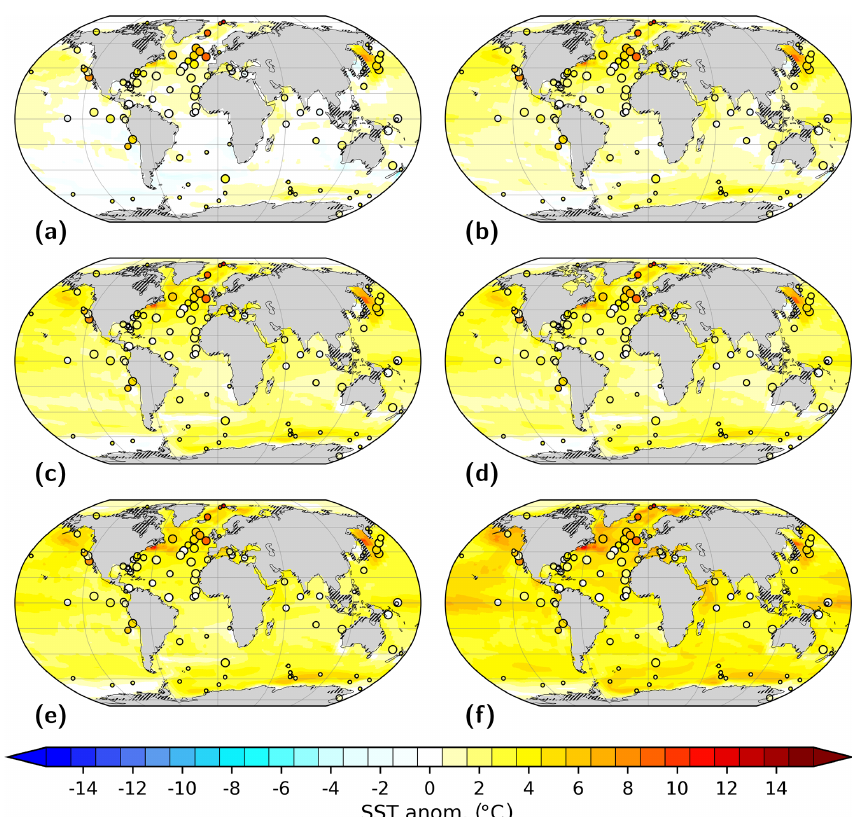
Figure 23. Comparison of modelled and reconstructed (PRISM3; Dowsett et al., 2009, 2013) sea surface temperature (SST) anomaly with respect to pre-industrial (PI, E280) for simulations (a) Eoi280, (b) Eoi350, (c) Eoi400, (d) Eoi400_GW, (e) Eoi450, and (f) Eoi560. Shading represents modelled annual mean SST anomaly. Circles illustrate the respective PRISM3 SST reconstruction, with the size of the circle indicating the associated degree of confidence (Dowsett et al., 2013) – higher confidence is represented by a larger circle. Grey shading illustrates the land–sea mask. Hatches over land indicate differences in land–sea configuration between a specific simulation and the PI reference. We define model SST as the temperature of the uppermost ocean layer centred around a depth of